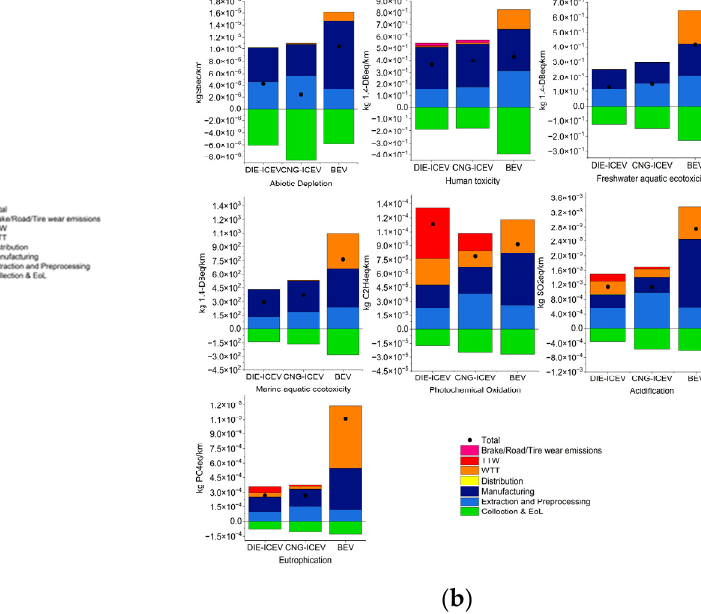
Figure 8. ( a ) Cradle-to-grave results for global warming for the three vehicles analyzed; ( b ) Cradle- to-grave results for the impact categories other than global warming for the three vehicles